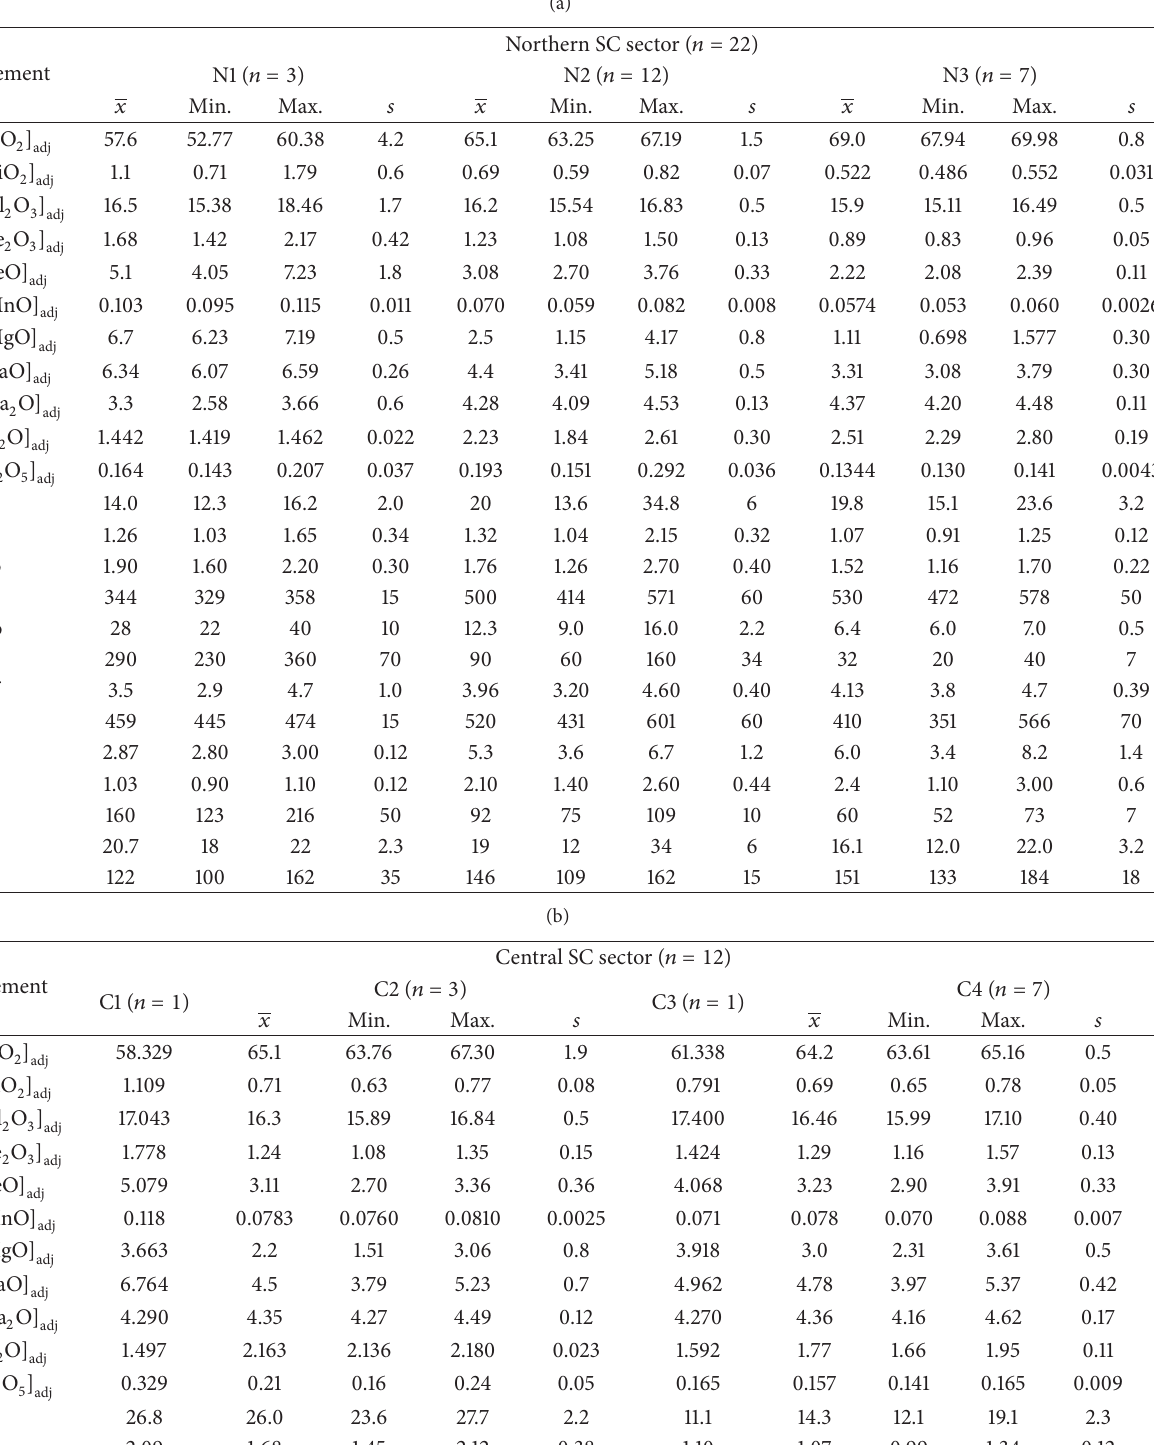
Table 6: Statistical parameters of major (%wt) and trace (ppm) element composition for the Sierra de las Cruces magmatic clusters.